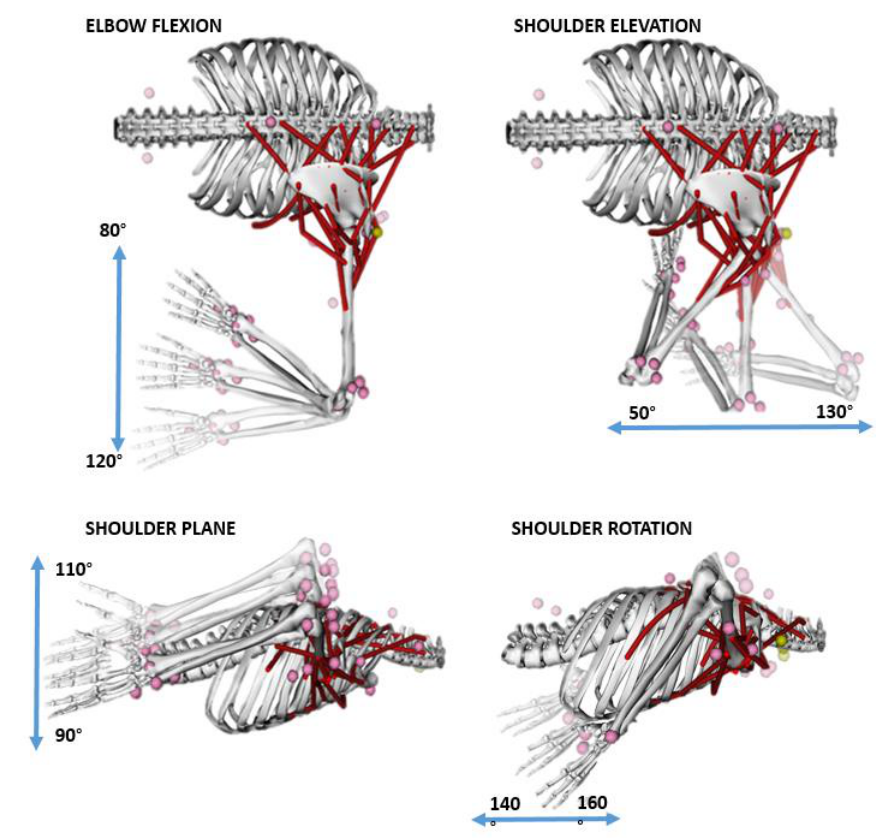
Figure 1. Joint range of motions explored in this